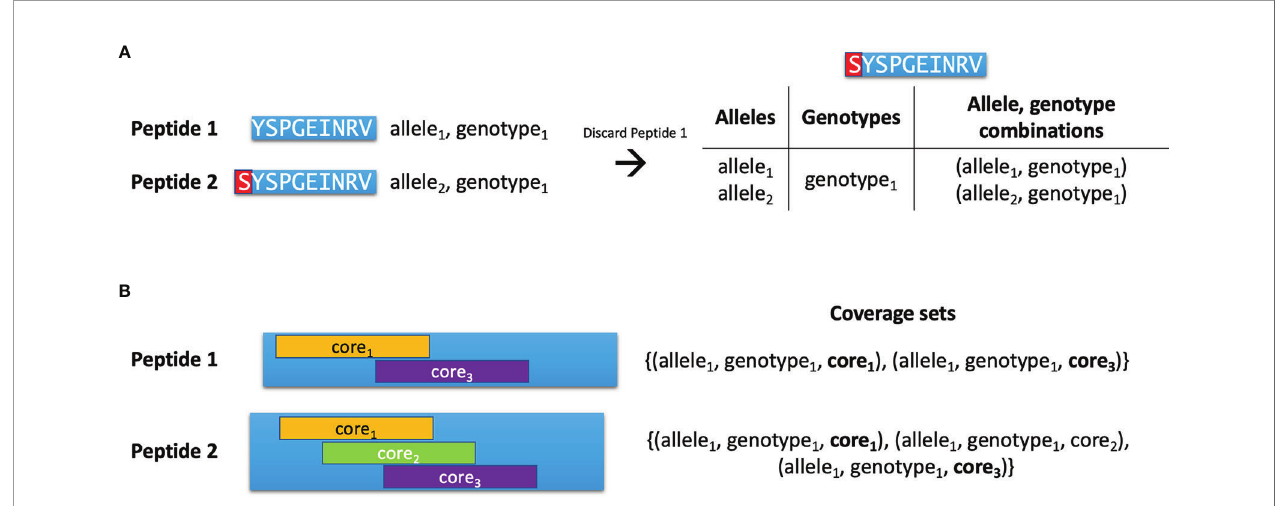
FIGURE 1 | Pairwise comparison of peptides. (A) Peptide 1 is an HLA-binder which is contained as a substring in Peptide 2, which is also an HLA binder. Peptide 1 is thus discarded, and Peptide 2 inherits the alleles and genotypes covered by Peptide 1. (B) Two peptides are compared during the Hobohm 1 algorithm. Peptide 2 has three binding cores and covers one allele and one genotype, yielding three combinations in its coverage set. Peptide 1 has two of the same binding cores as Peptide 2, and covers the same allele and genotype as Peptide 2, giving it two of the same combinations as Peptide 2. As such, the coverage set of Peptide 1 is a subset of Peptide 2 ’ s coverage set, and Peptide 1 is discarded due to it being functionally